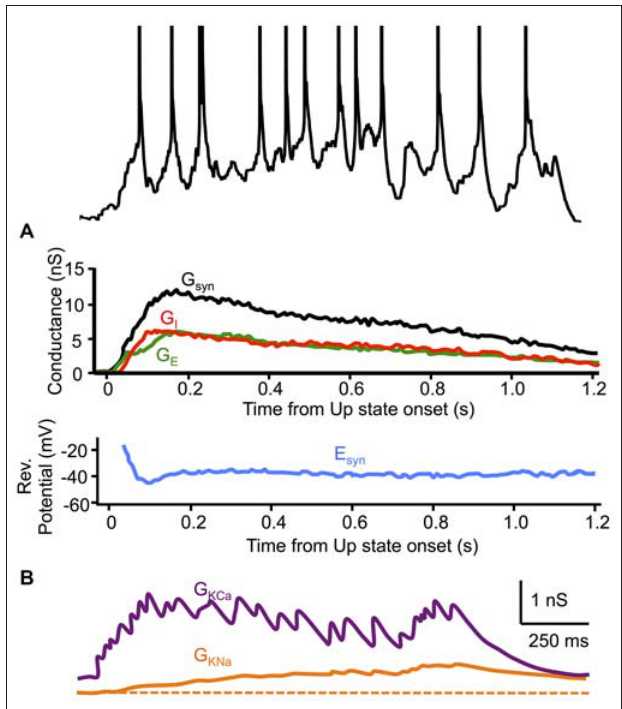
FIGURE 3 | Dynamics of synaptic and intrinsic conductances during Up states. (A) Excitatory and inhibitory synaptic conductances (G E and G I , respectively) (G syn = G E + G I ) decrease proportionally throughout the Up state, maintaining a relatively constant synaptic reversal potential (E syn ). Conductance estimates are from voltage-clamp recordings in cortical neurons of ferret visual or prefrontal cortex in vitro . (B) Two activity-dependent K + conductances (G KCa and G KNa ) are activated during Up states in a model recurrent cortical network. (A) adapted by permission from Macmillan Publishers Ltd: Nature (Shu et al., 2003b), © 2003. (B) adapted by permission from the American Physiological Society: Journal of Neurophysiology (Compte et al., 2003), ©